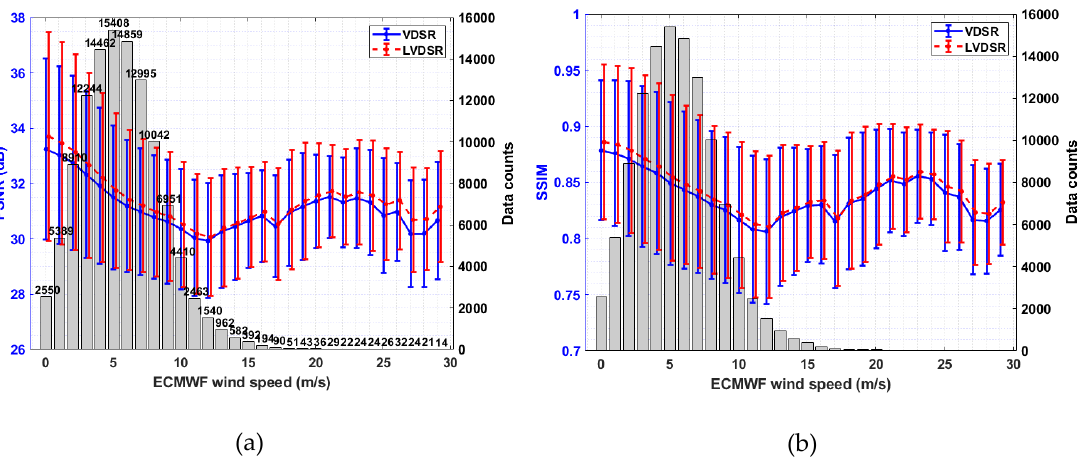
Figure 10. Example of incoherent ( a ) and coherent ( b ) DDM in the test data set. The measured incoherent FR-DDM has an SNR of 3.80 dB with an ECMWF wind speed of 29.90 m / s. The measured coherent FR-DDM has an SNR of 20.68 dB with an ECMWF wind speed of 2.92 m / s. (a) The PSNR and SSIM for this SR-DDM are respectively 29.95 dB and 0.80. (b) The PSNR and SSIM for this SR-DDM are respectively 36.82 dB and 0.87.